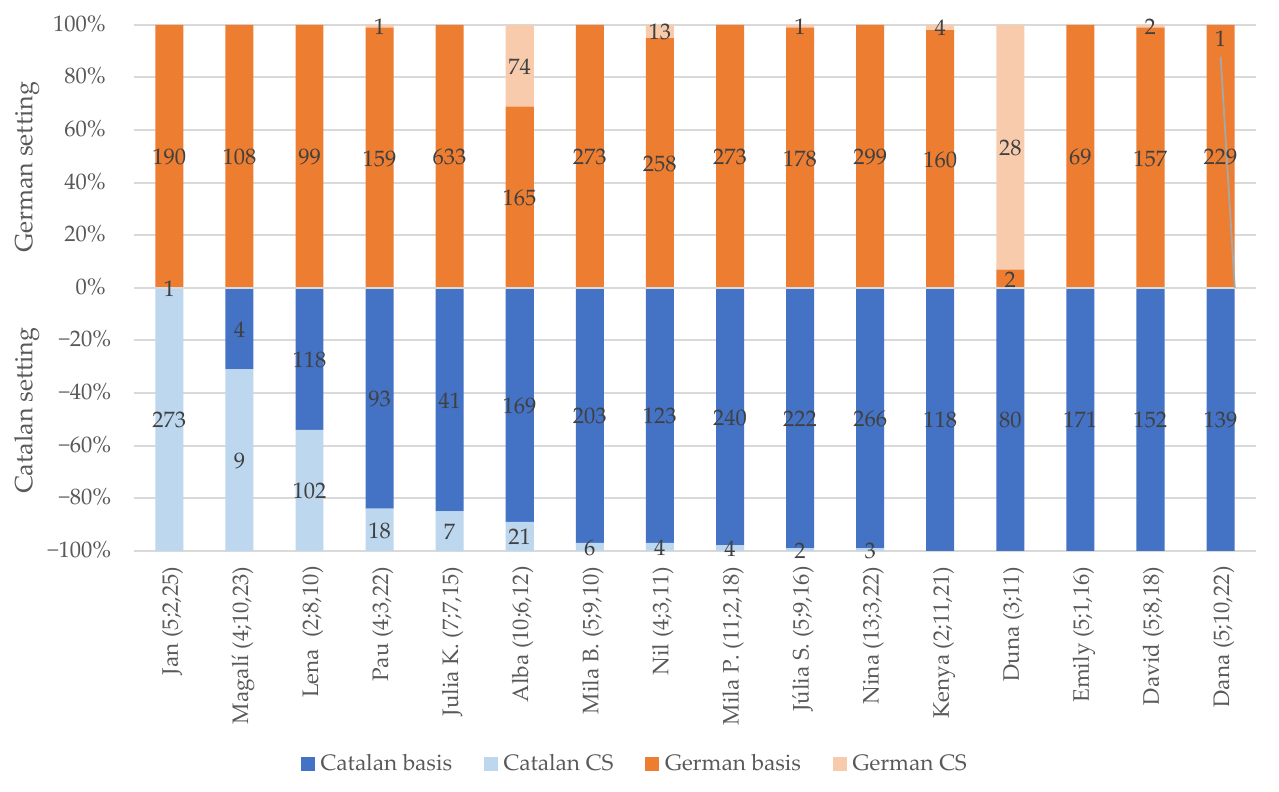
Figure 7. Total amount of monolingual productions (basis) and CS depending on the language of the recording for each child.